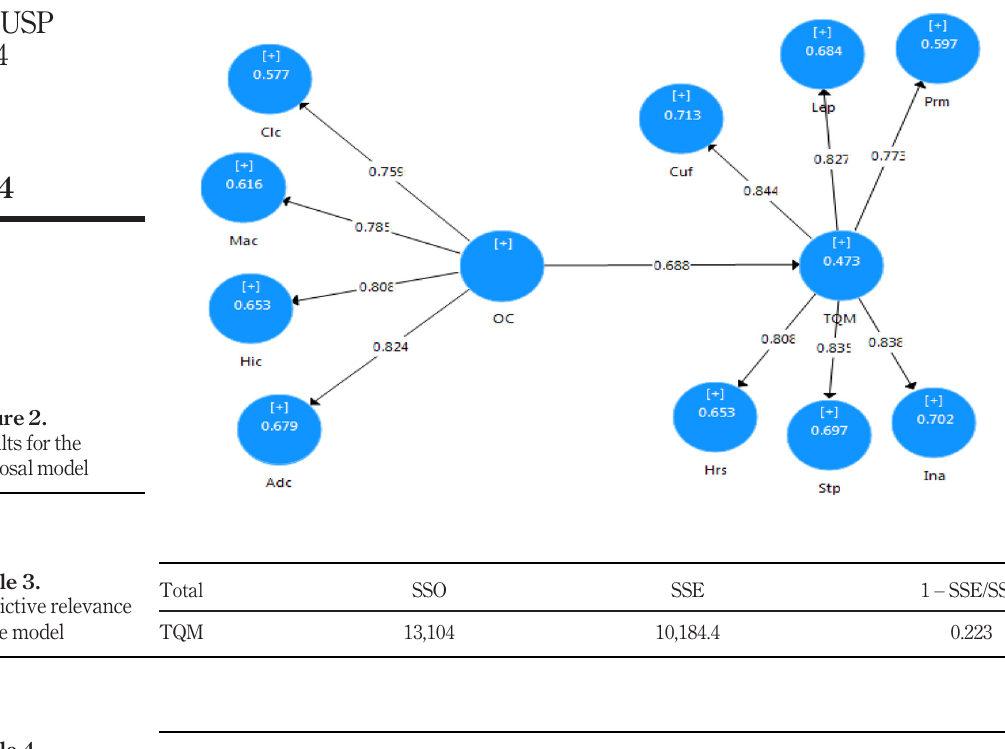
Table 4. Hypothesis